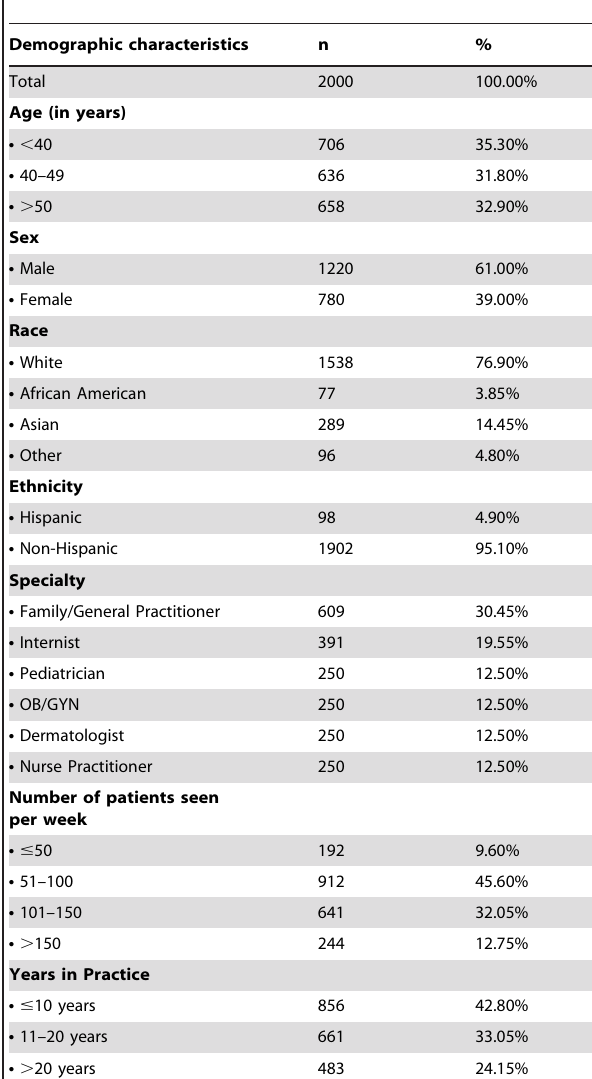
Table 1. Demographic and other characteristics of DocStyles respondents,